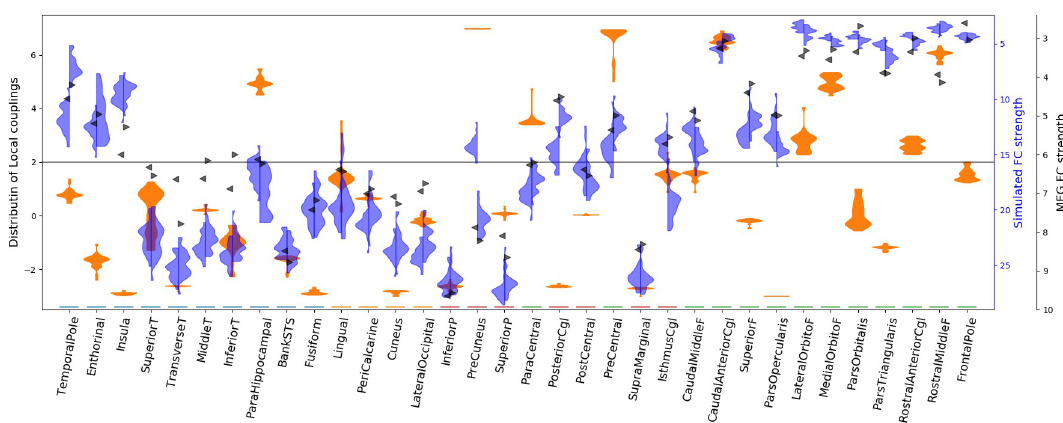
Fig 7. Density estimates of local couplings and functional connectivity strength by brain region. Each column on the x-axis is a brain region. In each column there are: one two-sided density in orange, two one-sided densities in blue (left/right), and two arrows in black. The orange density contains the same local couplings that are shown in orange in Fig 6. The magnitude of local coupling is indicated on the left y-axis. Blue densities represent the sFCS for these local couplings, left and right for each hemisphere. The black triangles indicate the MEG mean sFCS across subjects for each hemisphere. Both scales of FCS are on the right y-axis with the respective colors. The scales of sFCS are inverted to aid visual comparison with local couplings as they have a negative correlation (-0.46 and -0.40 for the right and left hemispheres respectively). The horizontal gray line indicates the critical local coupling.